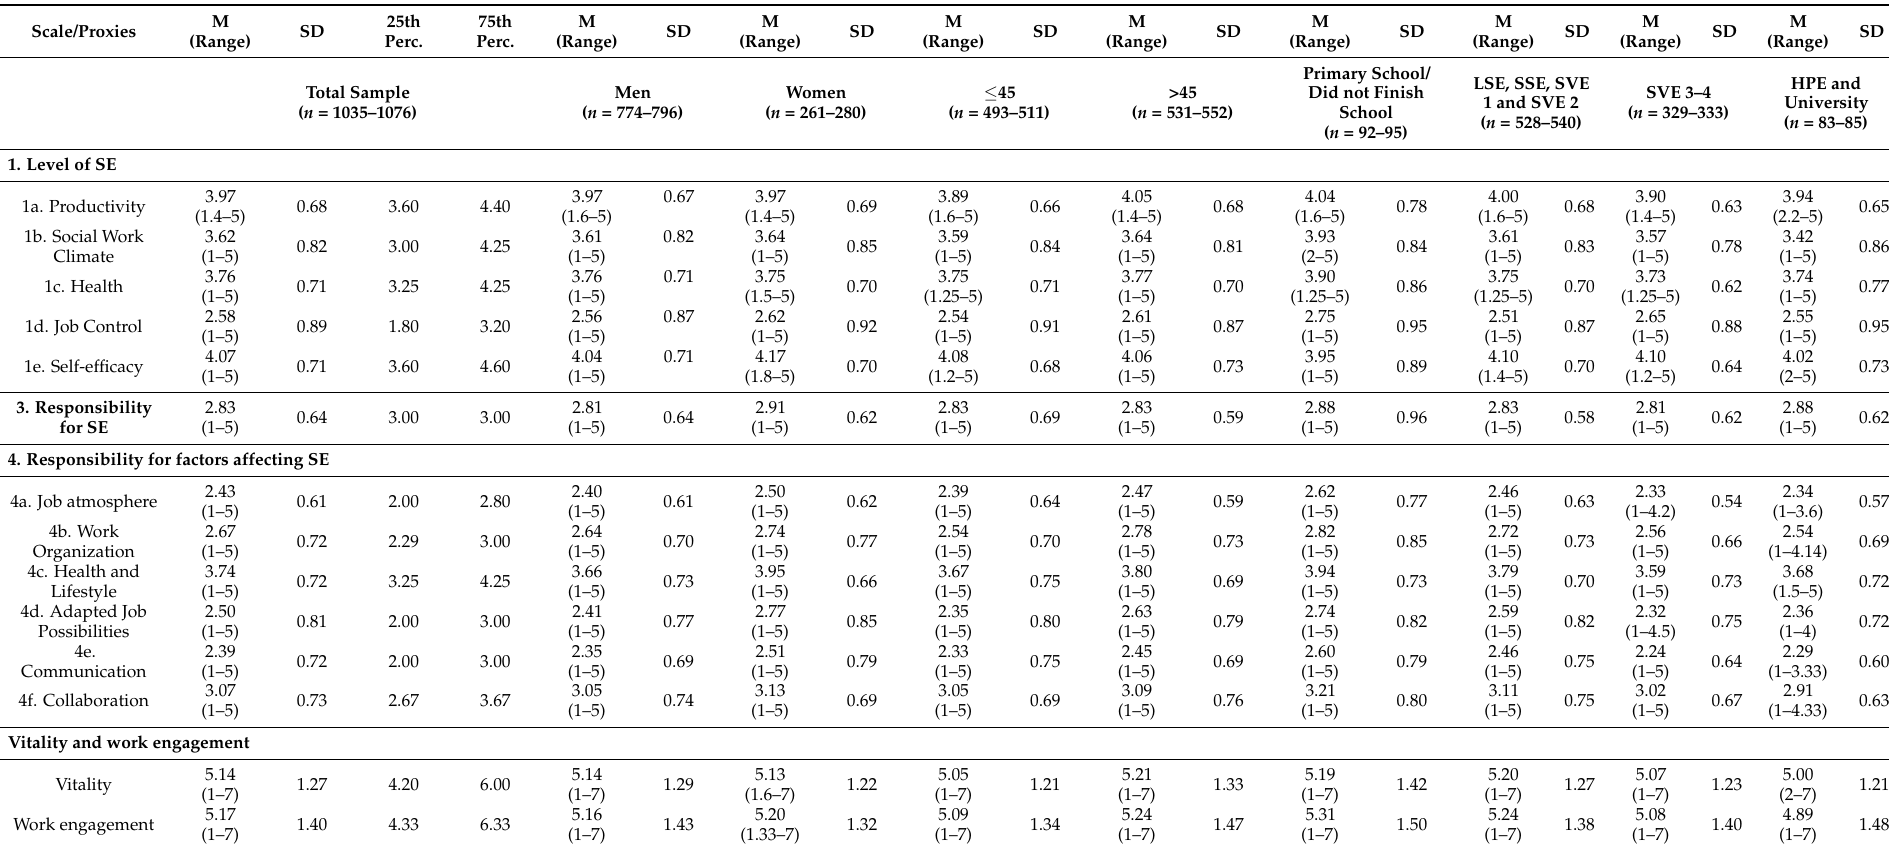
Table 7. Means (M), standard deviations (SD) and percentiles of the MAISE-Easy scales for the total sample and subgroups (gender, age, educational level) for Areas (1) level of SE, (3) responsibility for SE, (4) responsibility for factors affecting SE and for the criteria (vitality and work